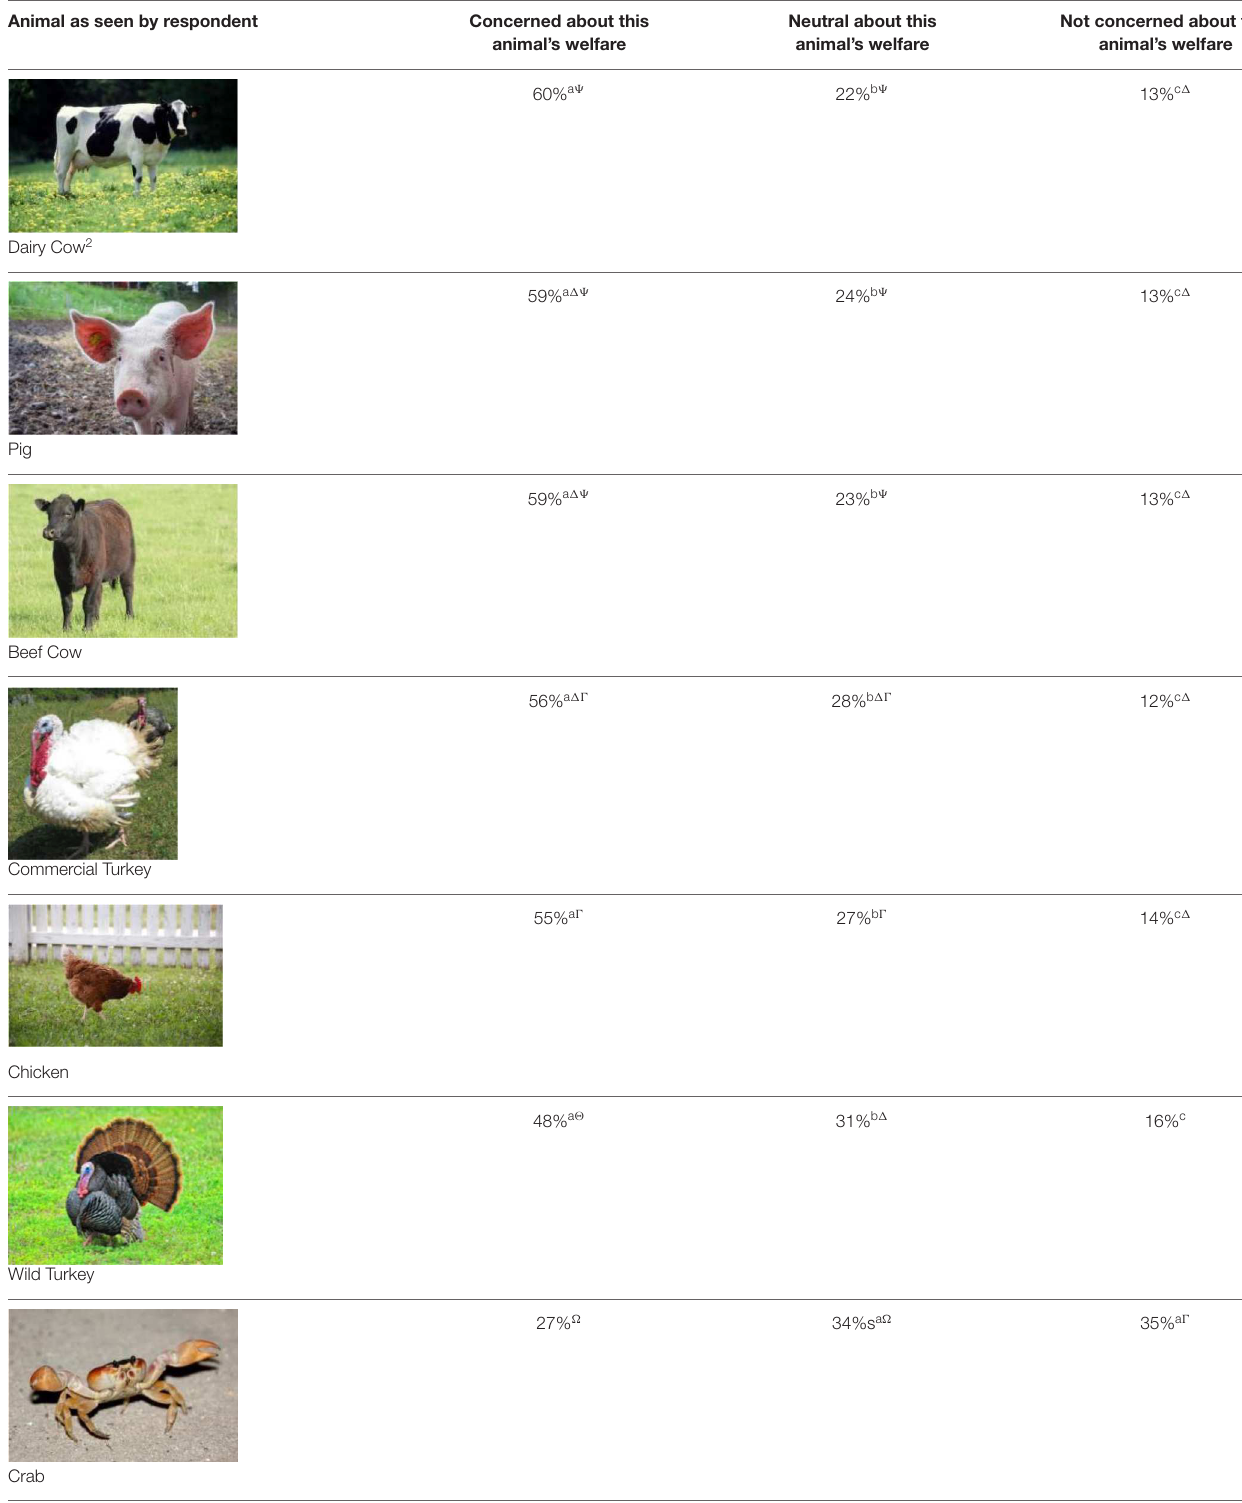
TABLE 7 | Level of concern regarding the welfare of the following animals 1